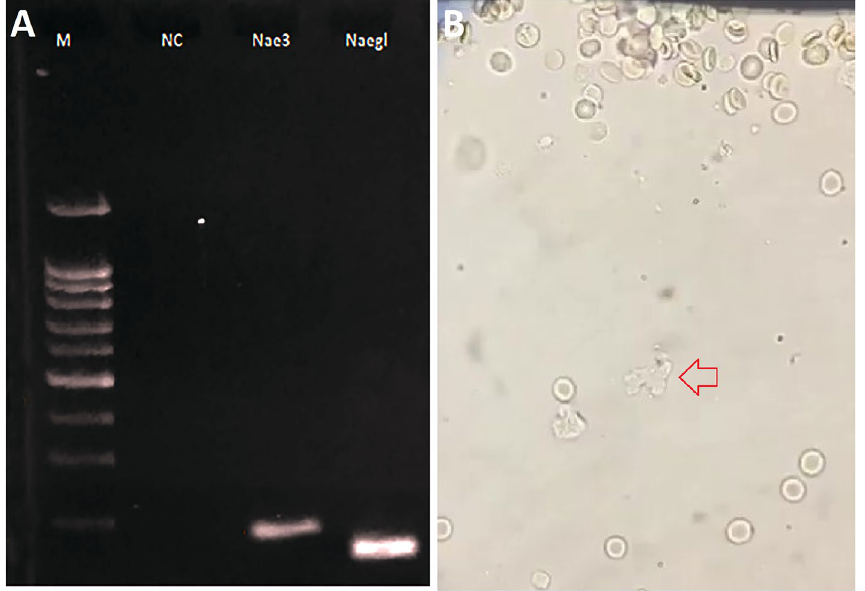
Figure 1. Agarose gel (2.0%) electrophoresis of the PCR products for analysis of patient CSF with primary amoebic meningoencephalitis (PAM) infection; line M: 100 bp DNA ladder, line NC: Negative control without DNA, line Nae3 (183 pb) and Naegl (153 bp): N. fowleri specific primers used for amplification of DNA from the patient CSF ( A ). Microscopy images: arrow indicating the N. fowleri observed in the patient CSF ( B